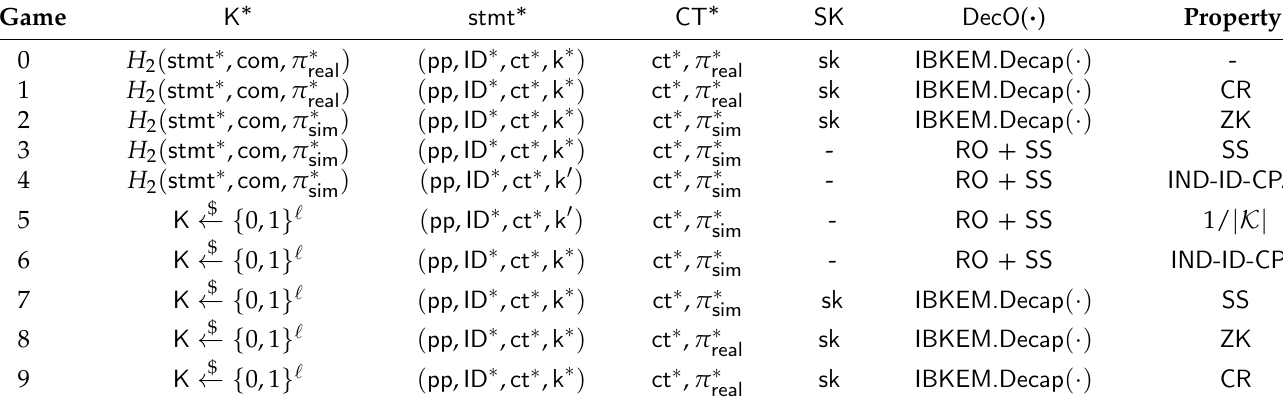
Table 2. Values or operations of K ∗ , CT ∗ , SK , and DecO ( · ) in each game and properties ensuring the indistinguishability of consecutive games. RO + SS denotes that the simulator retrieves k from a random oracle table and checks the validity of the ciphertext based on the SS